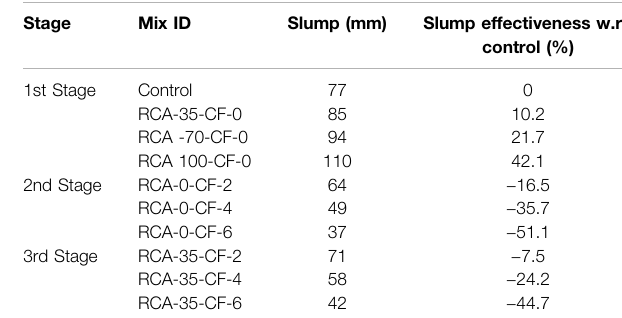
TABLE 4 | Slump values of all concrete